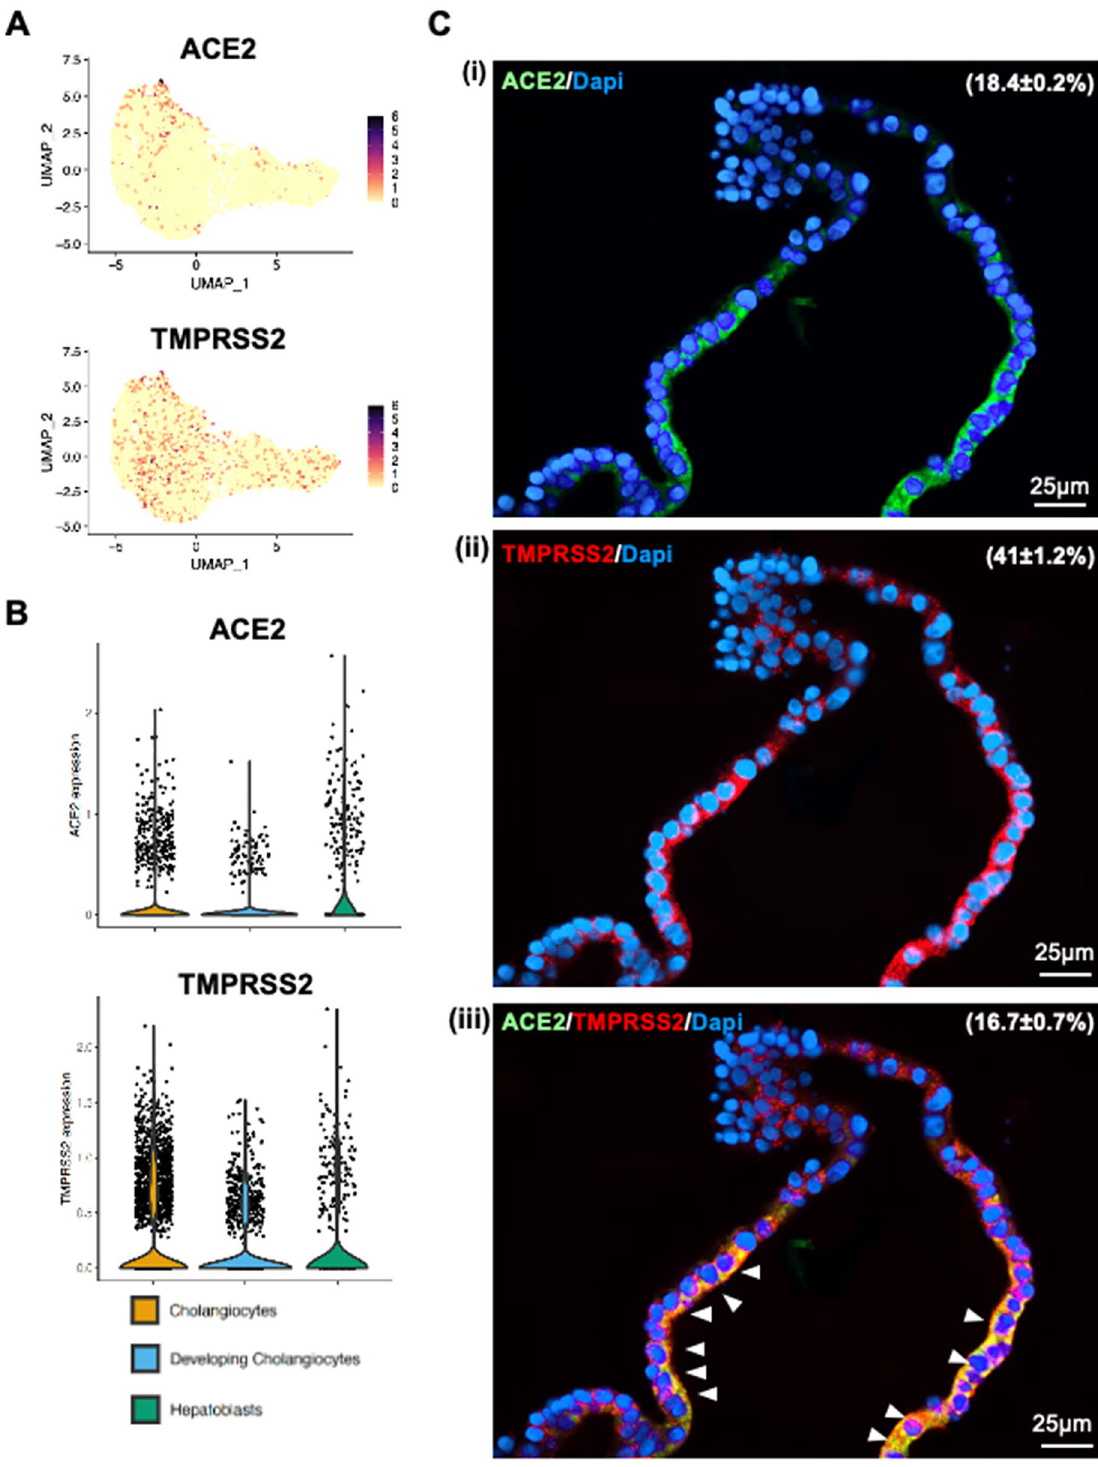
Figure 2. Human liver organoid cells expressed ACE2 and TMPRS2. ( A ) and ( B ) Feature plot and violin plot displaying single cell expression distributions for features (ACE2, TMPRSS2 and TMPRSS4) in each cluster of cells from liver organoids. ( C ) Co-immunofluorescence staining of human liver organoids for ACE2 and TMPRSS2. Parenthesis indicated the percentages of organoid cells that expressed ACE2 (i), TMPRSS2 (ii) and ACE2 plus TMPRSS2 (iii). Arrowheads, organoid cells that co-expressed ACE2 and